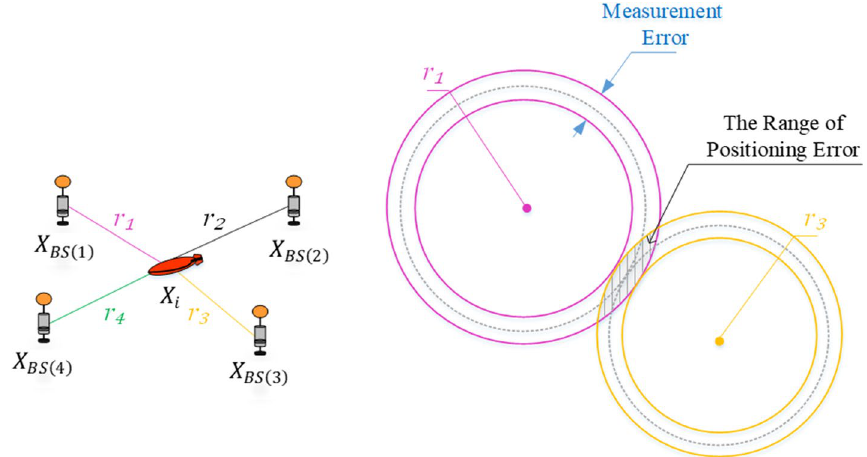
Fig. 2 Decentralized baseline and positioning error